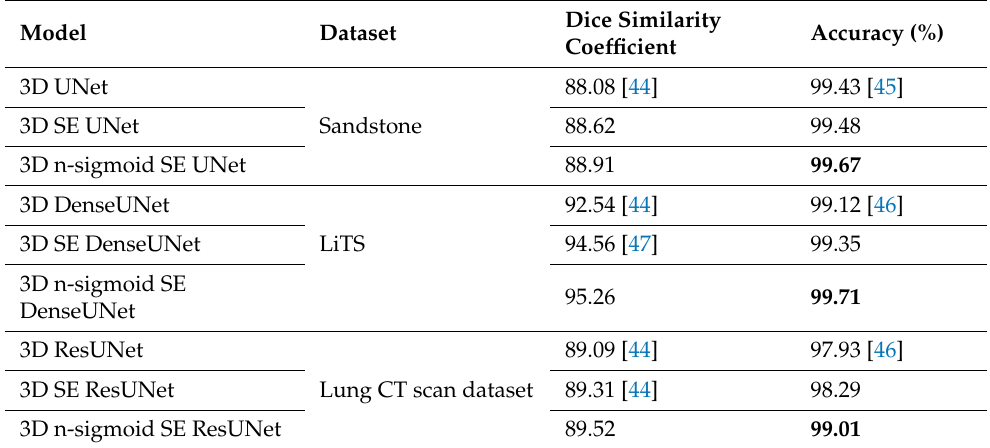
Table 4. Segmentation accuracy and Dice similarity coefficient (DSC) results comparison.